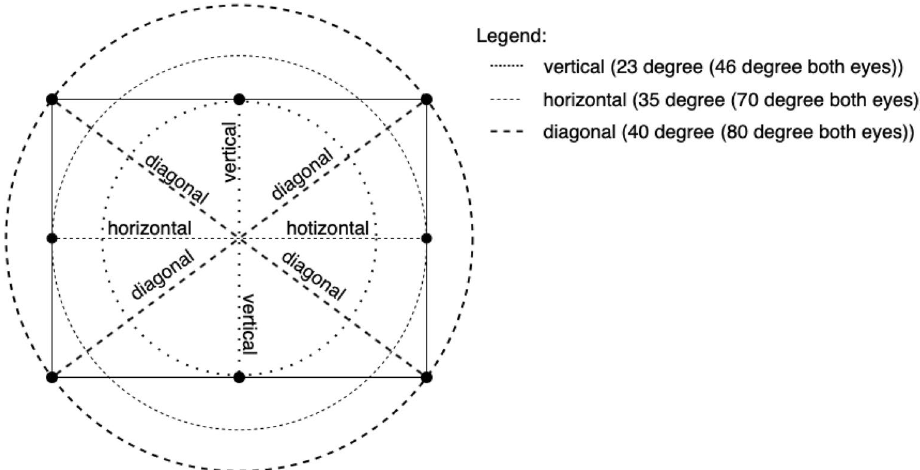
Figure 12. Position of the disc: The solid line that forms the rectangle is the outline of the screen on which the experiment was displayed. Black dots are discs displayed with varying frequency and contrast variations. Dashed lines represent specific angular distances (in degrees) for the following degrees of angle binocular vision 2 )) for the middle of the bottom and top edges of the screen, horizontal (70° (disc position): vertical (46° ( 23 × 2 )) for the middle of right and left edges of the screen, and diagonal (80° ( 40 ( 35 × the